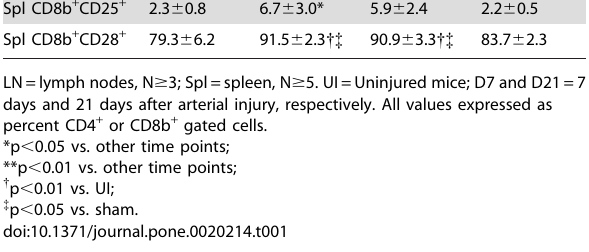
(Fig. 1B, top panel) and spleen (Fig. 1B, bottom panel) significantly increased 7 days after injury then decreased 21 days after injury (Fig. 1B and Table 1). Splenic CD8b + CD25 + T cells also increased significantly 7 days after injury and decreased back to uninjured levels at day 21 (Fig. 2A, top panel and Table 1). CD8b + CD28 + T cells in the spleen were significantly increased within a week after injury (Fig. 2A, bottom panel and Table 1) and remained elevated 21 days after injury. In addition, CD8b + T cells in the spleen of WT mice had significantly increased CD28 expression 7 days after injury compared with uninjured mice (Fig. 2B and C), suggesting not only increased number but increased CD28 expression as well. There were no significant changes in the percentage of CD8b + T cells in the sham group (Figs. 1 and 2 and Table 1).